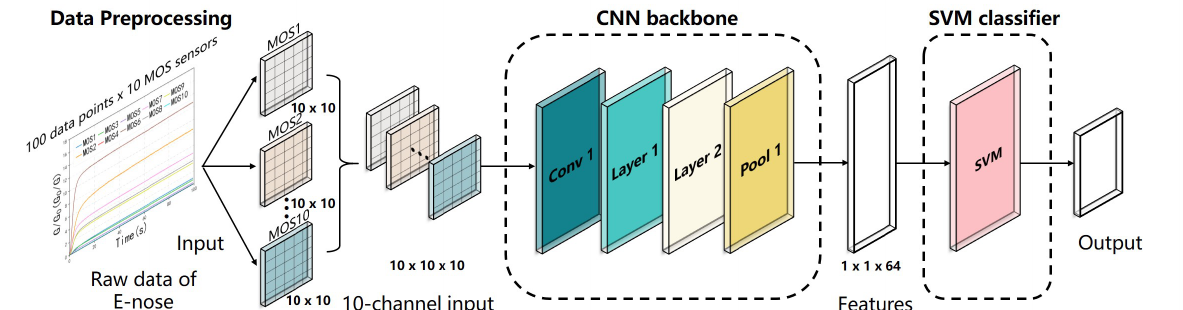
Figure 7. Schematic diagram of the CNN-SVM